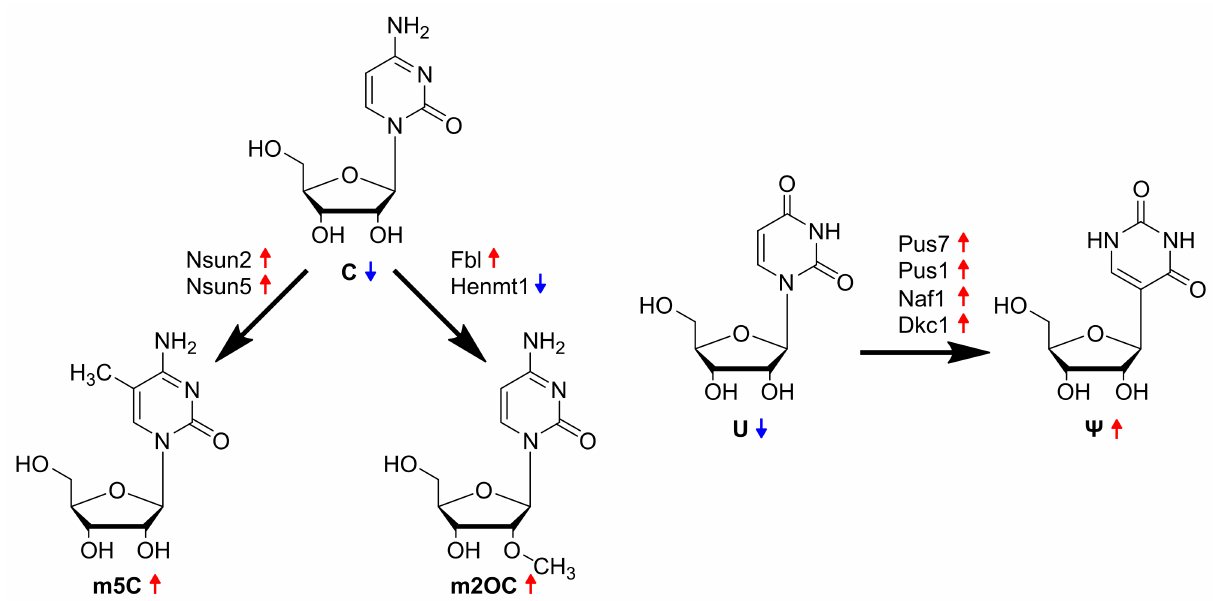
Figure 6. Summary of key findings: In ccRCC cells derived from the VPR mouse model, the modified nucleosides m5C, m2OC and Ψ , in addition to others, are excreted to the extracellular space. Accordingly, their unmodified precursor nucleosides C and U are reduced (indicated by a blue arrow pointing downwards). Several nucleoside-modifying enzymes responsible for these conversions are elevated in VPR cancer cells (indicated by a red arrow pointing